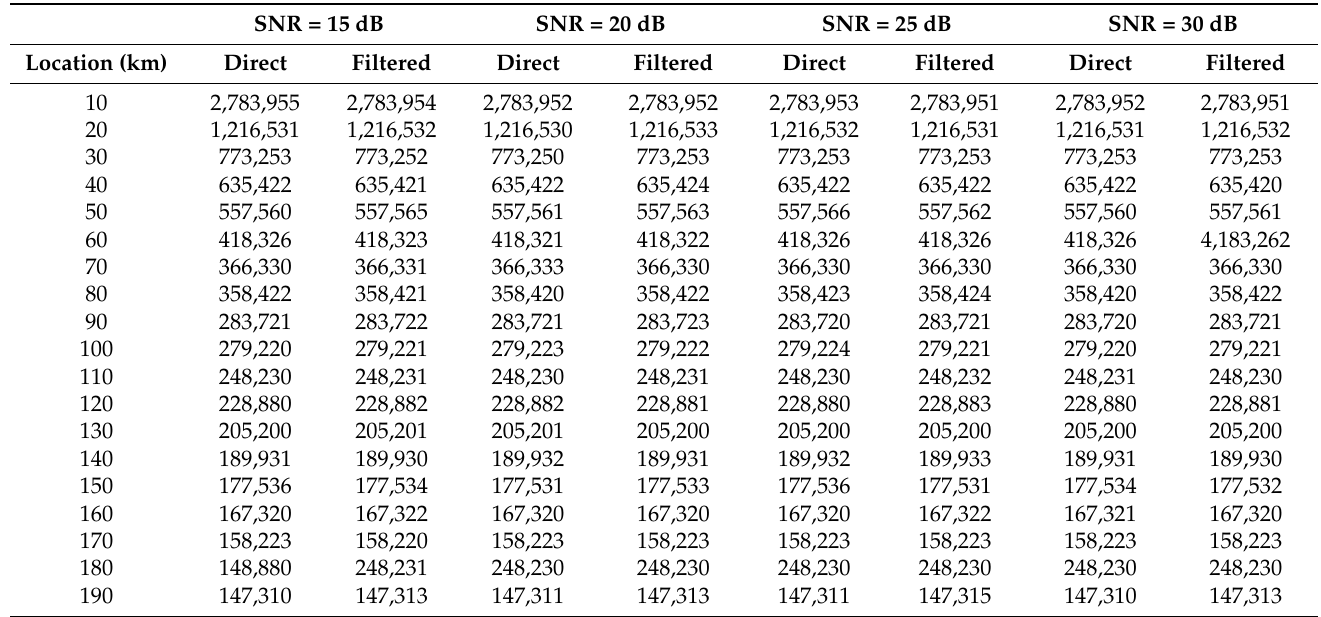
Table A1. Max singular value of FRFT-SVD results at various SNRs for direct and filtered signals under LL fault